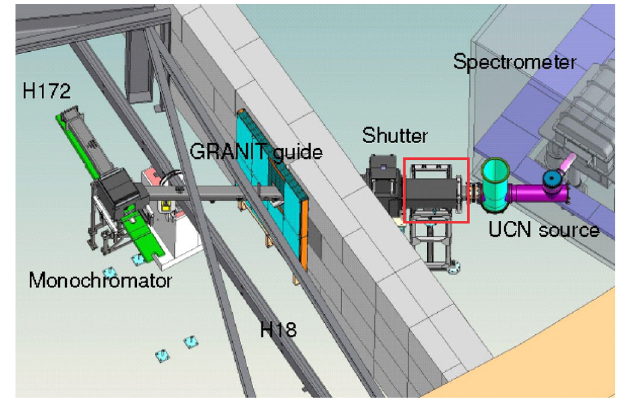
FIG. 1. Sketch of the GRANIT beamline. Neutrons come from the top left corner through the H172 guide (only its last section is shown). The large box at its end contains the monochromator crystal. The 0.89 nm neutron beam exits to beam-left, and ends just before the converter volume of the UCN source. For neutron wavelength spectrum measurements, its last element (marked with a red rectangle in the drawing) has been replaced with the TOF device described in this